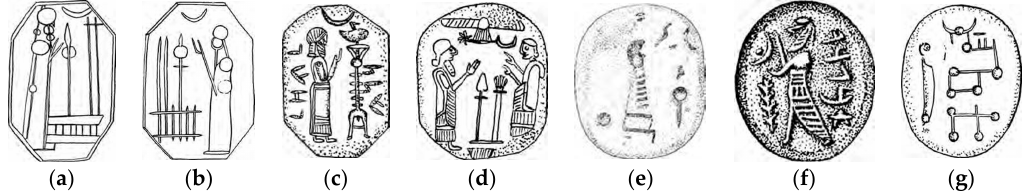
Figure 5. Stamp seals with worshipper and crescent moon: ( a ) ʿ Amman 3; ( b ) Meqabelein 1; ( c ) Tall al-Mazar 1; ( d ) Tall al-Mazar 14; ( e ) Tall al- ʿ Umeiri 51; ( f ) Tall al- ʿ Umeiri 52; ( g ) Umm Udeina 5.